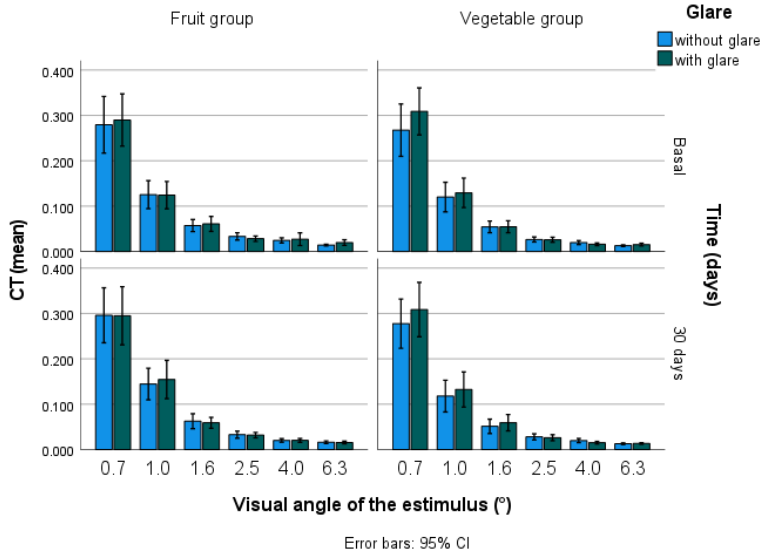
Figure 1. Contrast threshold at different degrees of visual angle, without and with glare, at the beginning and the end of the study.